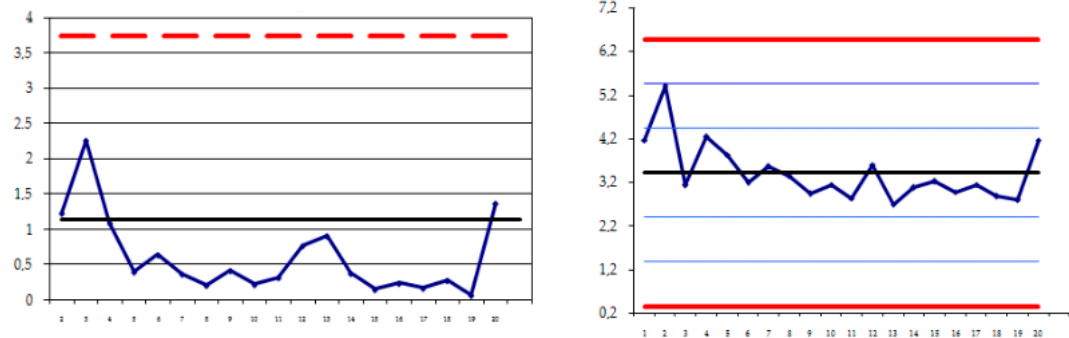
Figure 3. Shewhart’s control charts for autonomy ratio (author’s study).